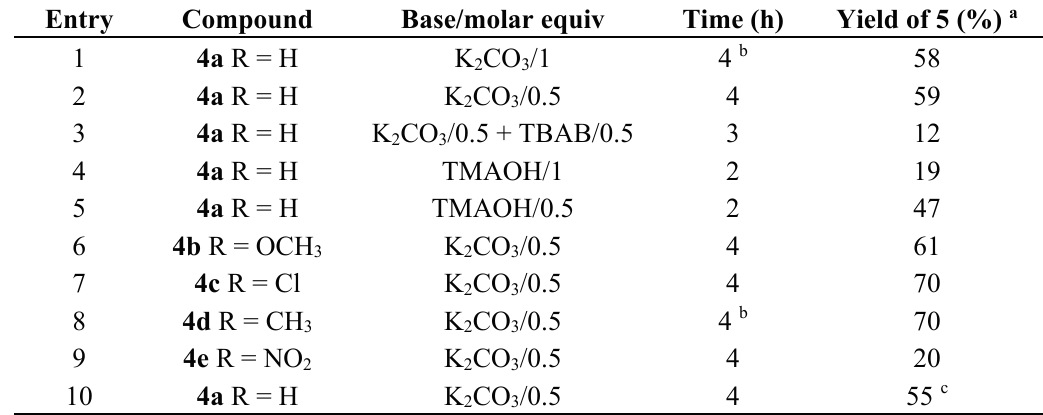
Table 1. Cyclodehydration of 5-aryl-1-(2-hydroxyphenyl)pent-4-ene-1,3-diones 4a – e to ( E )-2-styrylchromones 5a – e in water, using classical reflux heating